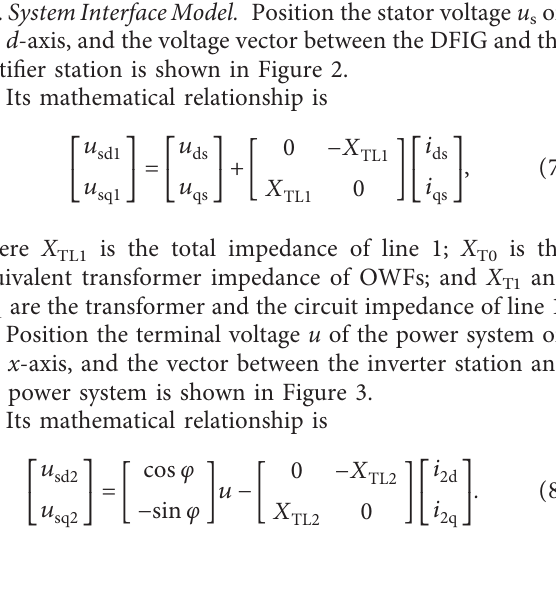
Figure 3: The voltage vector between the inverter station and the power system.